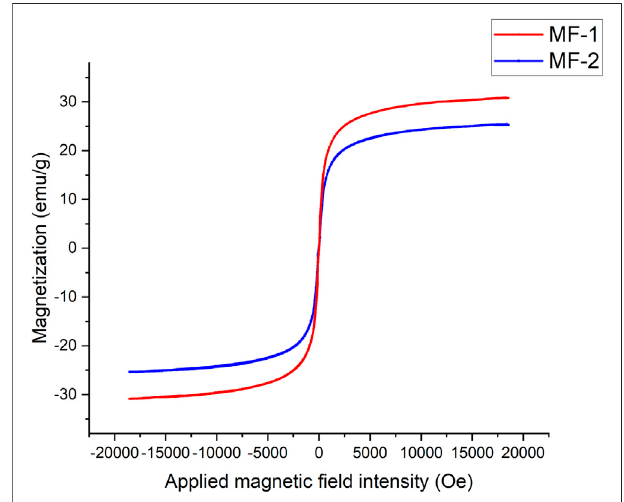
FIGURE 1 | M – H curves of MF-1 and